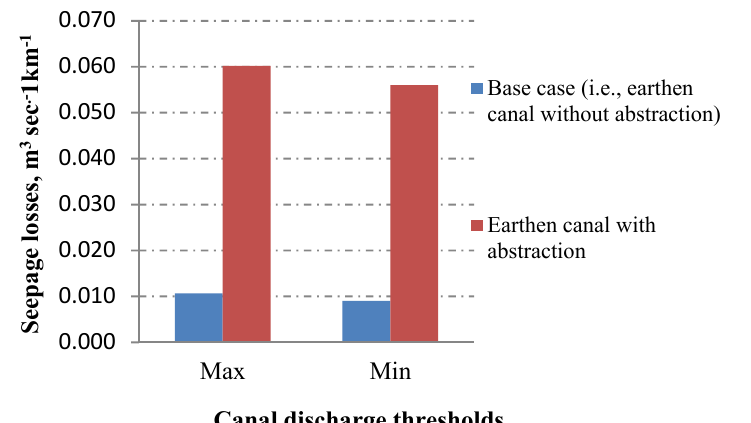
Figure 6. Canal seepage losses under well extraction.